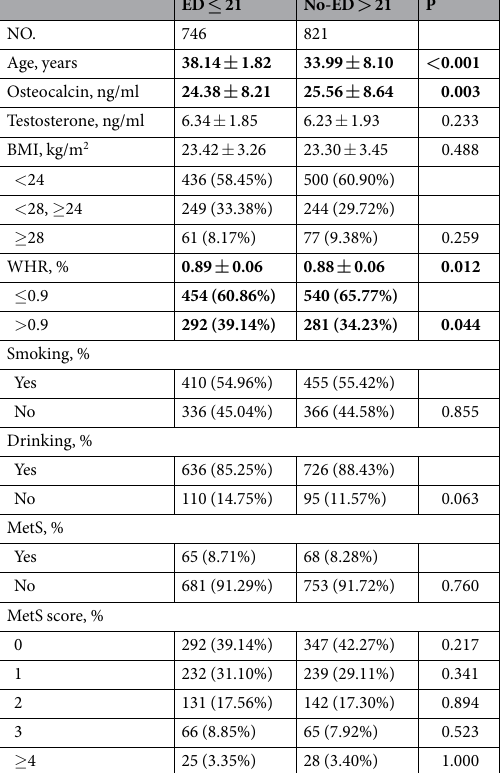
Table 1. The baseline analysis for the eligible participants in this study. * The ED is defined with the threshold of IIEF-5 of 22 score. * Quantitative traits represented as mean ± SD are tested with student’s t test. Qualitative traits are tested with chi-square test. * ED: erectile dysfunction; BMI: body mass index; WHR: waist hip rate; SD: standard